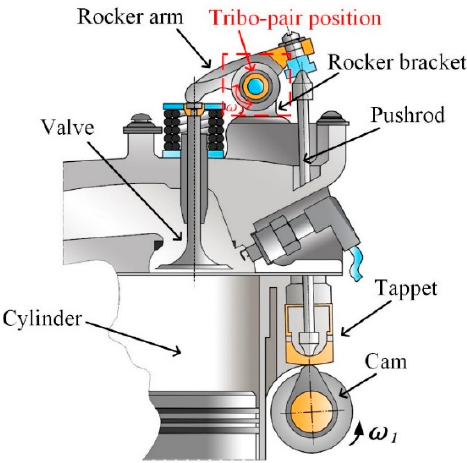
Figure 1. Position of valve rocker–valve rocker bracket tribo-pair.